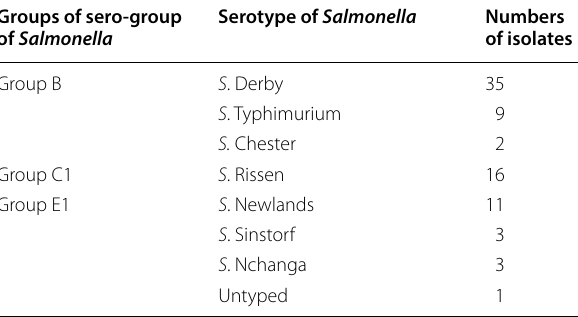
Table 3 Serotype distribution of the Salmonella isolates Groups of sero-group Serotype of of Salmonella